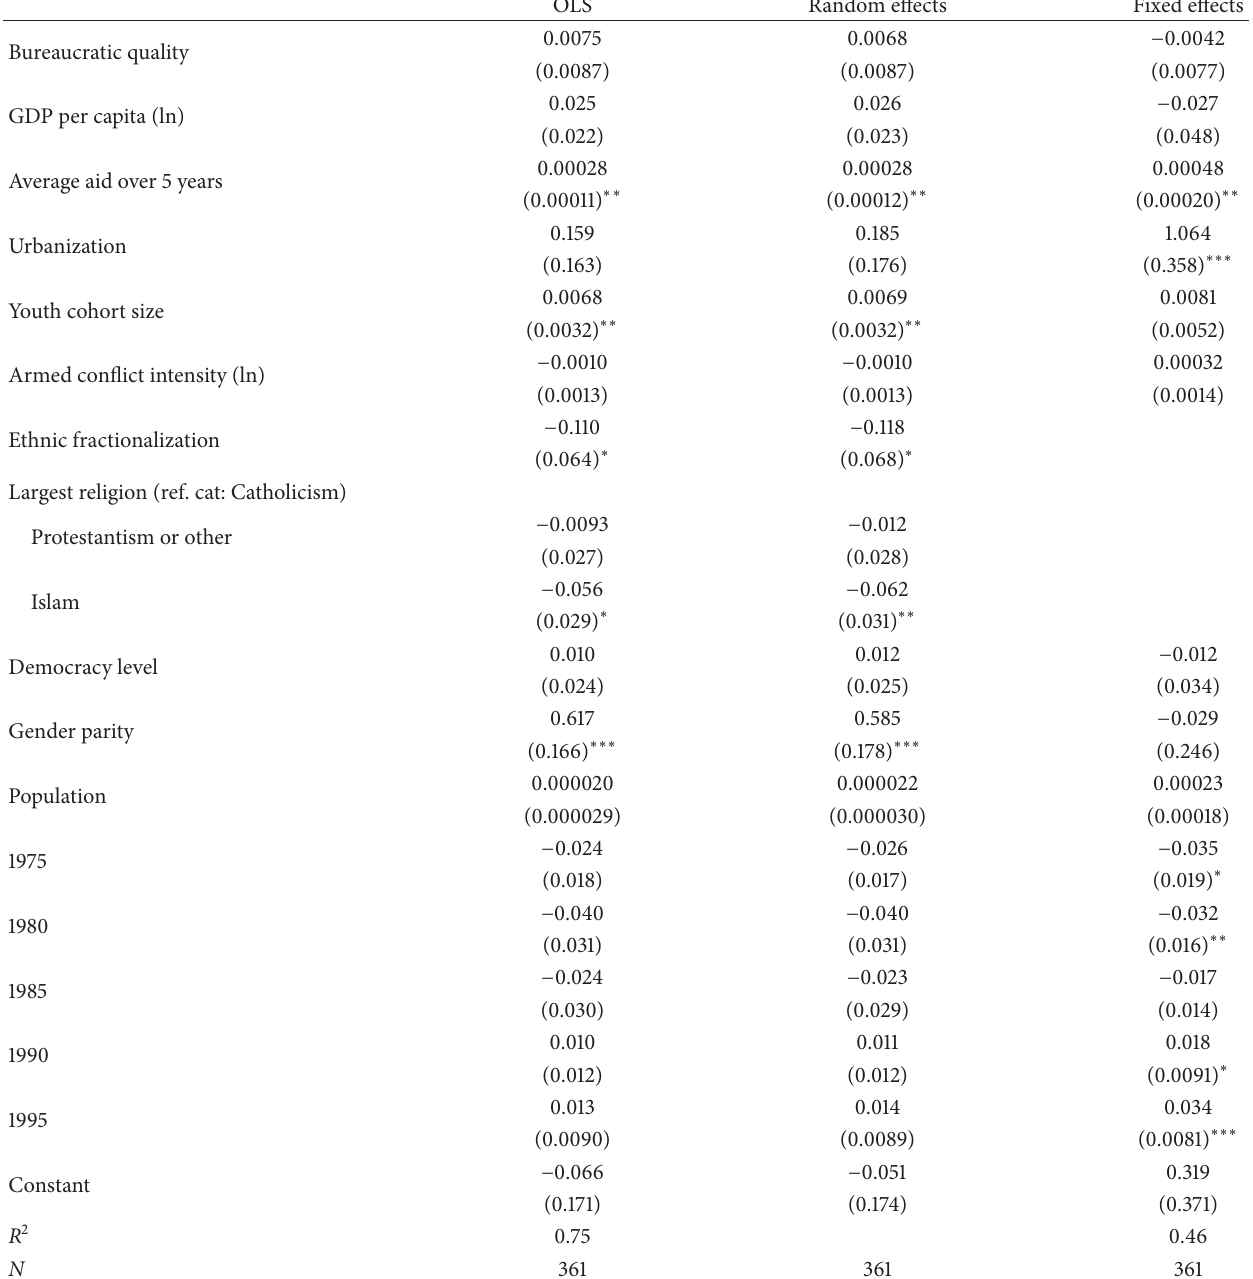
Table 7: Gender parity in secondary education attainment, developing countries: 1970–2010. Lagged dependent variable